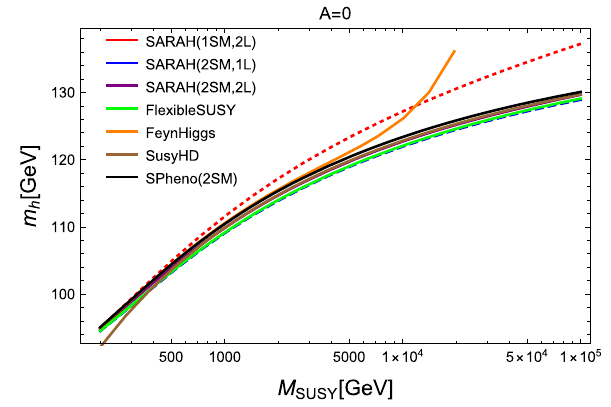
Fig. 8 The Higgs mass prediction of different computer codes as a function of the SUSY mass. The dashed red line corresponds to the old prediction by SARAH /